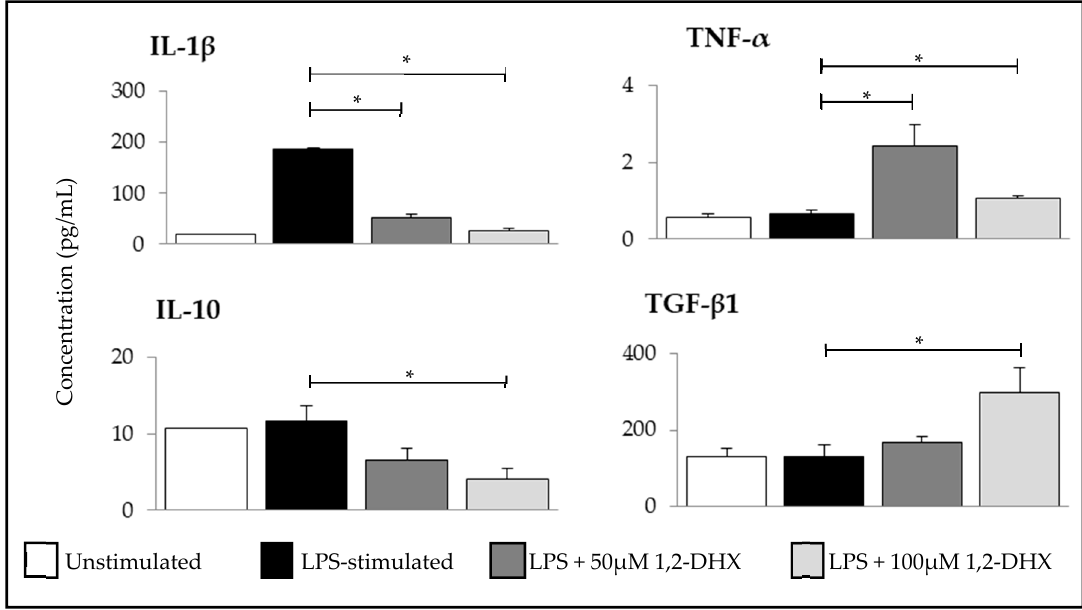
Figure 3. E ff ects of 1,2-dihydroxyxanthone (1,2-DHX) on IL-1 β , IL-10, TGF- β 1, and TNF- α production by THP-1 macrophages. Cytokine production was evaluated after 24 h incubation with unstimulated macrophages (basal), LPS-stimulated macrophages (positive control), and LPS-stimulated macrophages treated with 1,2-DHX (50 or 100 µ M). Data are the mean ± SEM from one experiment, performed with duplicate cultures, and are representative of three experiments carried out independently. * p <